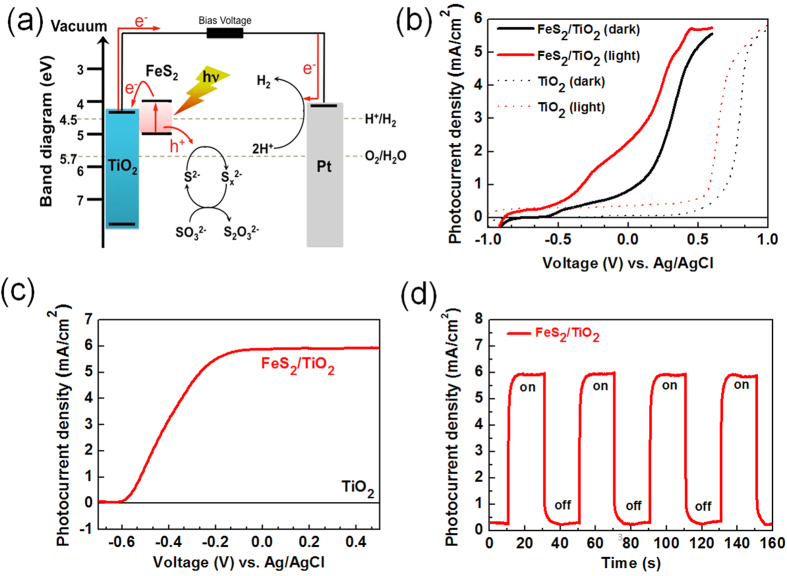
(a) Schematic illustration of the PEC device with a FeS2/TiO2 photoanode, and a passive Pt cathode, for light driven water splitting in aqueous solution. (b) The photocurrent–potential (I–V) responses of FeS2/TiO2 photoanode and pure TiO2 in the alkaline electrolyte (pH = 13.5) with SO32−/S2O32− as sacrificial agent under simulated AM 1.5 illumination (100 mW/cm2). (c) The photocurrent–potential (I–V) responses of FeS2/TiO2, and TiO2 photoanodes in the alkaline electrolyte (pH = 13.5) with SO32−/S2O32− as sacrificial agent under NIR laser (808 nm) illumination (300 mW/cm2). (d) Light chopping photocurrent measurements in a three electrode cell using FeS2/TiO2 photoanode as working electrode.